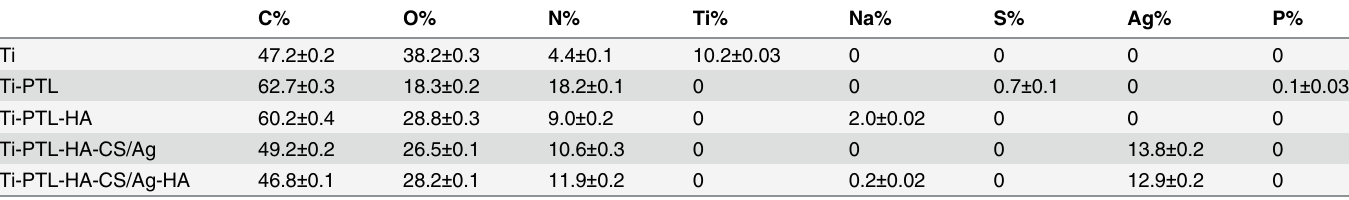
Table 1. Elemental composition at the surface of various Ti discs with different treatments as determined by